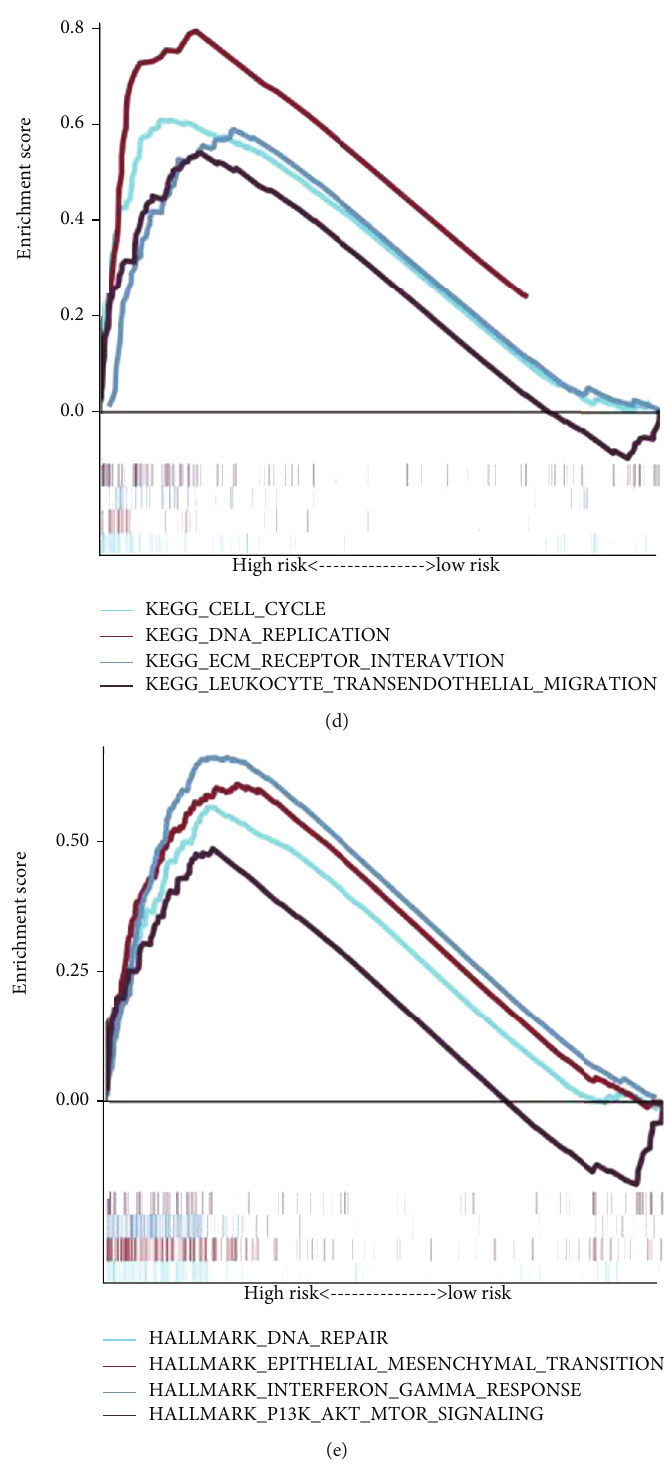
Figure 10: IRRG signature-related biological functions and enriched pathways. (a) The regulatory network involving eight genes and 20 potential binding proteins was constructed using the GeneMANIA database. (b) GO and KEGG analyses for 28 genes. GSEA shows the signi fi cantly enriched processes and pathways in (c) Gene Ontology analysis, (d) Kyoto Encyclopedia of Genes and Genomes analysis, and (e) Hallmark gene set analysis based on the IRRG